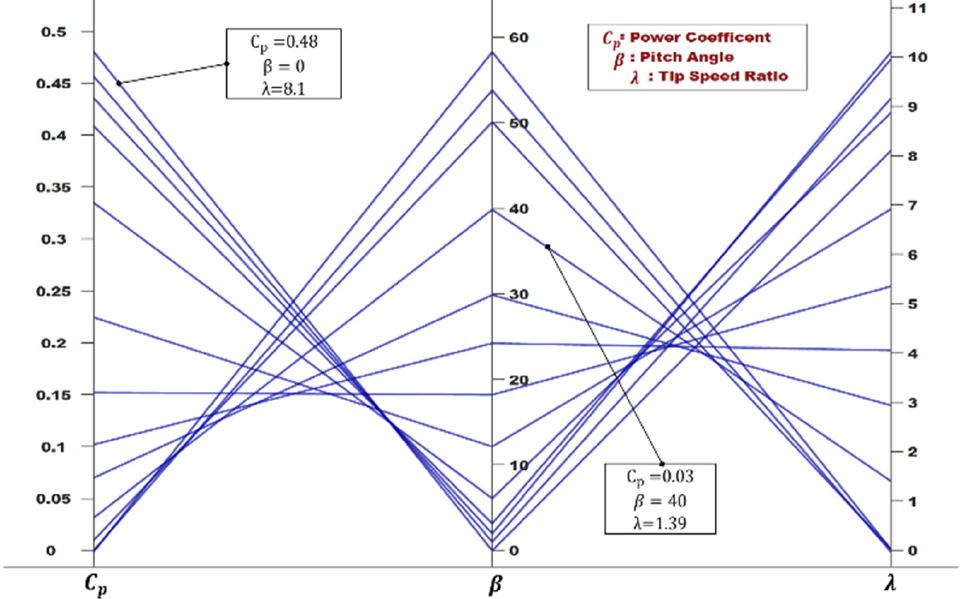
Figure 3. Variation in the optimal value of the Cp with β and λ .